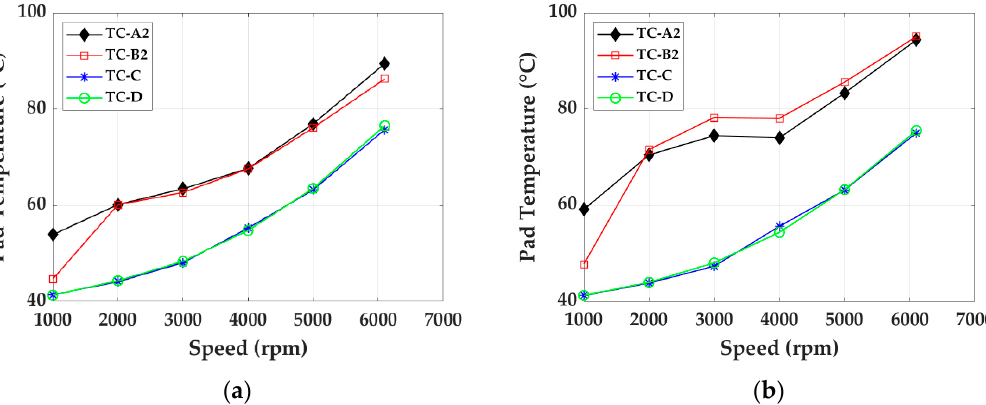
Figure 20. Flooded Ball & Socket Pivot bearing pad temperatures @ 75% of pad arc: ( a ) 1.0 MPa, ( b ) 1.7 MPa.